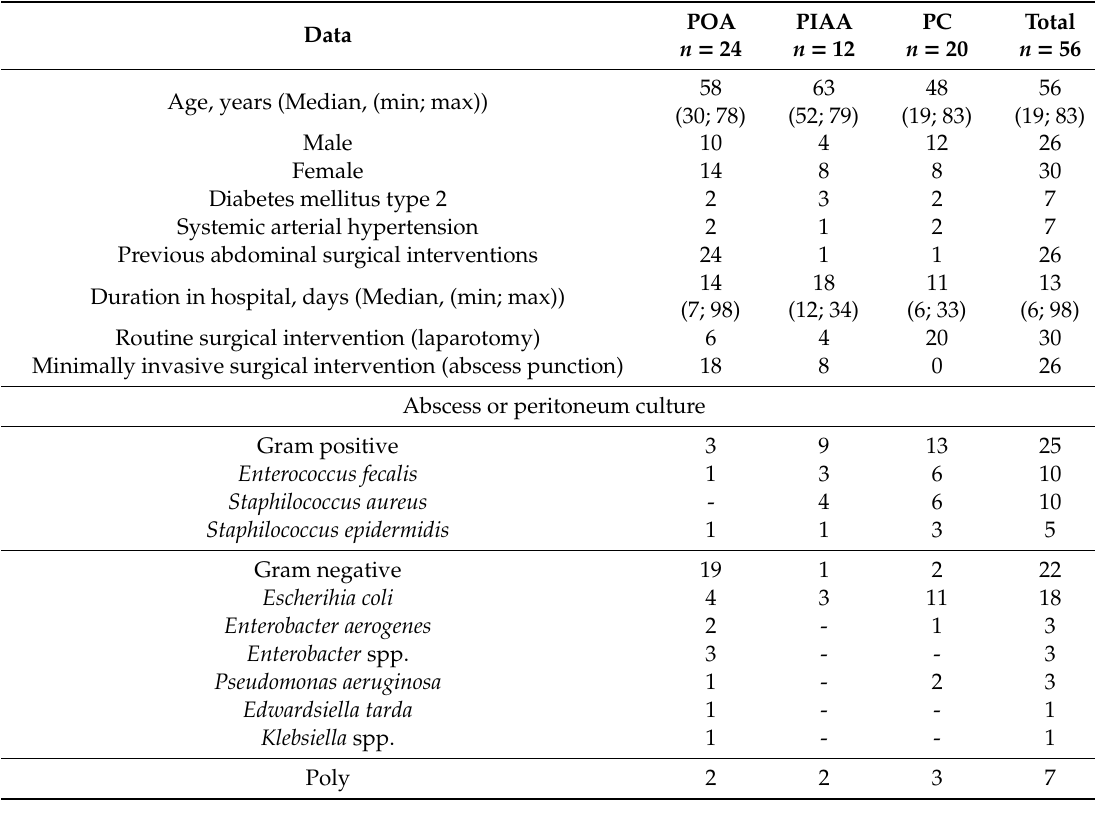
Table 1. Demographic and clinical variables of patients with di ff erent origin of intra-abdominal infections